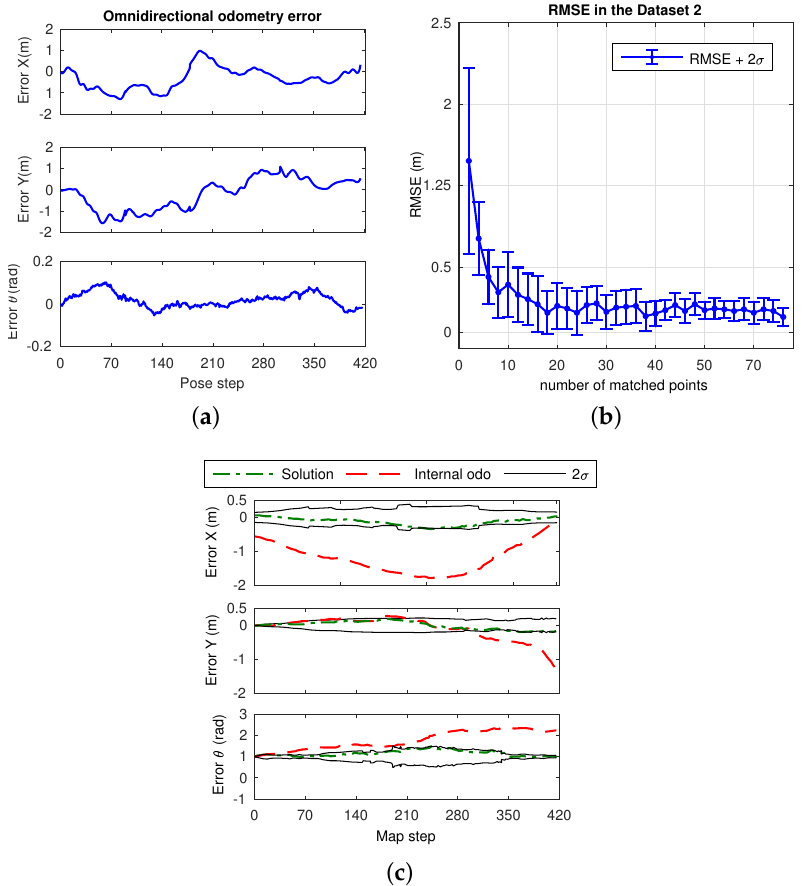
Figure 20. Error results in Dataset 2: ( a ) error in the omnidirectional visual odometry (Figure 19a), in X , Y and θ ; ( b ) RMSE (m) for the omnidirectional odometry with 2 σ versus the number of matched points; ( c ) error terms for the SLAM estimation presented in Figure